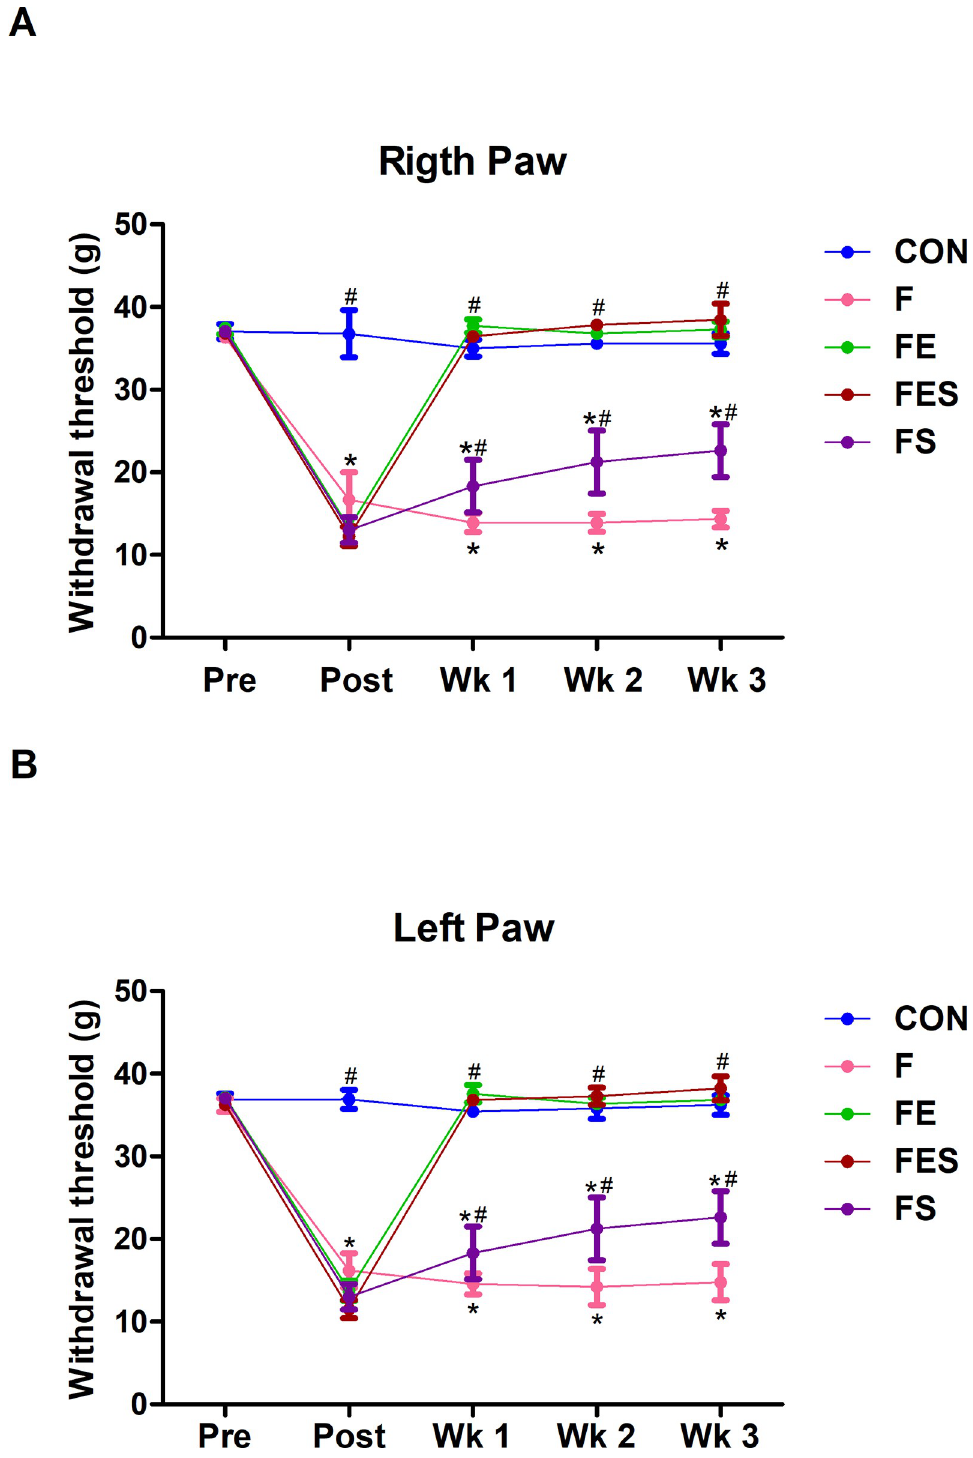
Fig 1. Mechanical hyperalgesia. (A) Withdrawal threshold of right paw. (B) Withdrawal threshold of left paw. CON, control; F, fibromyalgia induced; FE, fibromyalgia induced plus exercise; FES, fibromyalgia induced plus exercise and TRP supplementation; FS, fibromyalgia induced plus TRP supplementation; PRE, pre-injection; POST, post-injection. The data are means ± SD from 8 animals in each group. � p < 0.05 vs CON group. # p < 0.05 vs F group (ANOVA two-way repeated measures, followed by Bonferroni post hoc